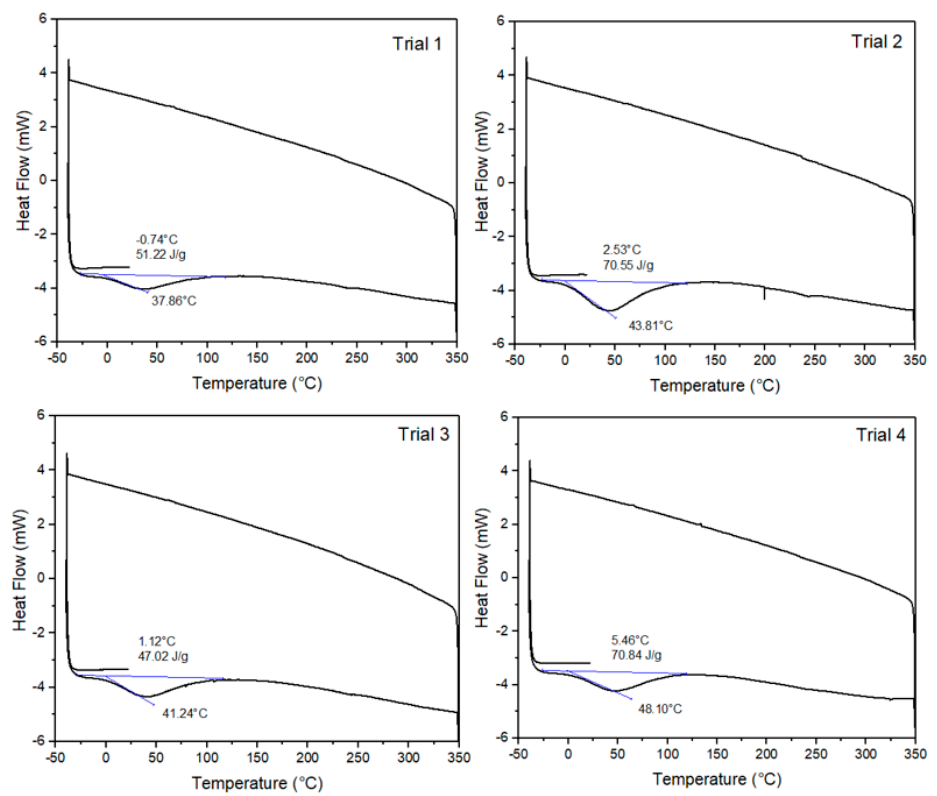
Figure 10. DSC profiles of the pyrolyzed samples (exo up).